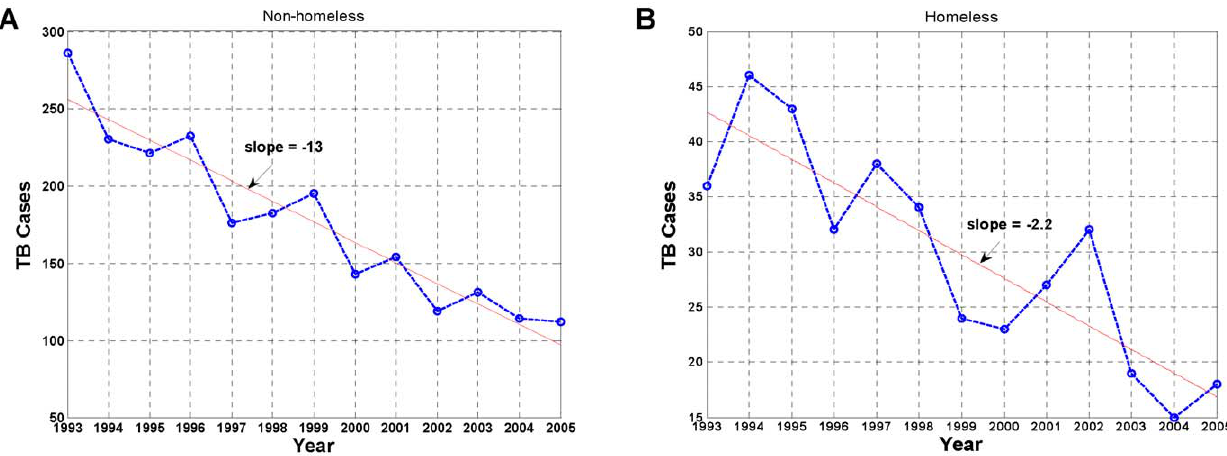
Figure 1. Annual number of TB cases in San Francisco, January 1993–December 2005. (A) Non-homeless: general population, exclusive of homeless. (B) Homeless. The rate of decline over time in the number of TB cases is much faster for the non-homeless than that of the homeless. Red line: linear fit.